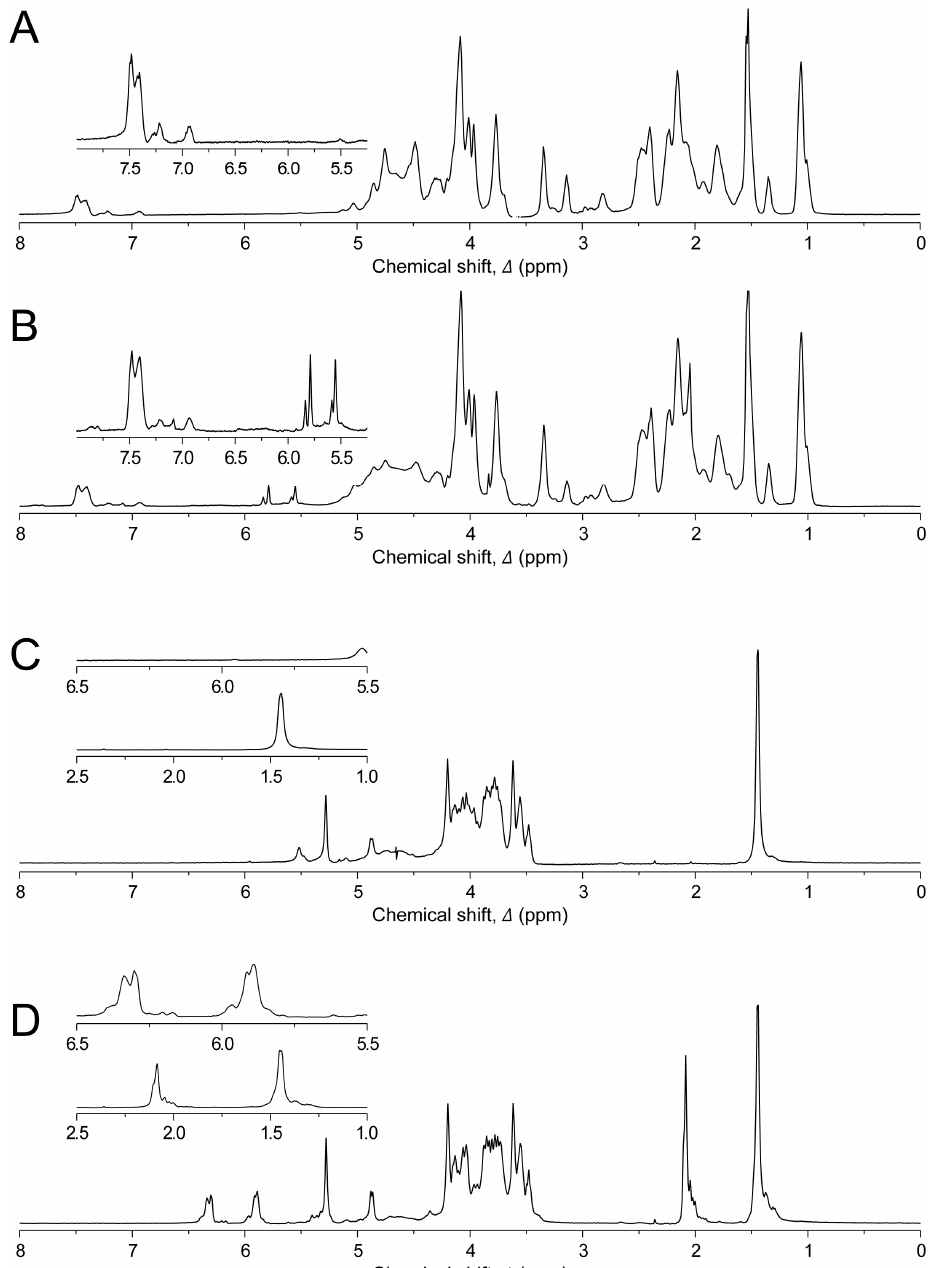
Figure 1. Proton nuclear magnetic resonance ( 1 H NMR) spectra of hydrogels. ( A ) gelatin; ( B ) gelatin methacrylamide (GelMA); ( C ) gellan gum (GG); and ( D ) gellan gum methacrylate (GGMA). Areas of interest are inset within each frame. Aromatic peaks in gelatin/GelMA are present at ~chemical shift ( δ ) 7.4 ppm, with the two free protons on the methacrylate groups present at δ 5.6 and 5.8 ppm respectively. In GG, the peak from the methyl group of rhamnose is present at δ 1.4 ppm, with the methyl group of the methacrylate group present in GGMA at δ 2.1 ppm. The C=C associated protons are also shown in GGMA at δ 5.8 and 6.3 ppm.